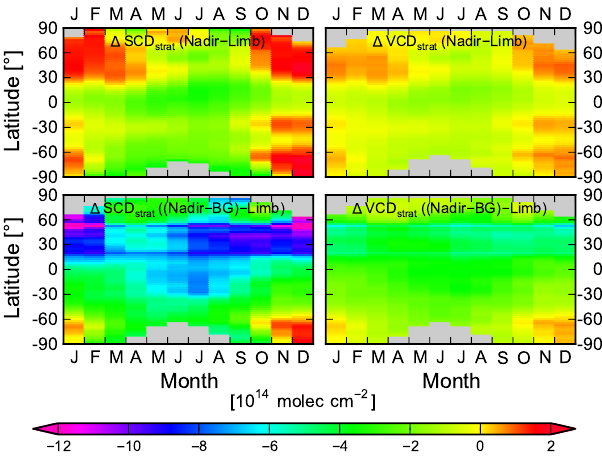
Fig. 7. Monthly climatology of the difference between SCIAMACHY nadir and limb measurements over the Pacific Ocean (180 ◦ W–150 ◦ W), averaged from the years 2004–2010 and gridded into 2.5 ◦ latitude bins. ∆VCD strat (left)and ∆SCD strat (right), “raw” columns (top) and after subtracting the tropospheric influence from the Oslo CTM2 climatology